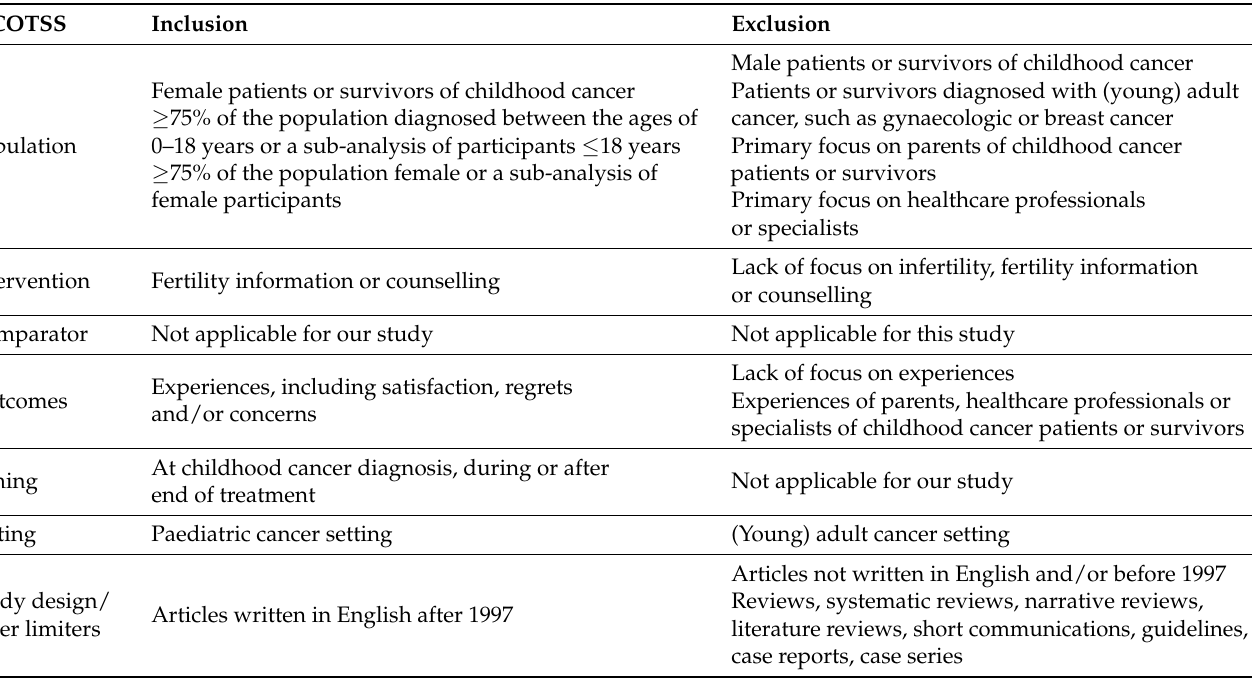
Table 1. Inclusion and exclusion criteria for studies using the PICOTSS Framework